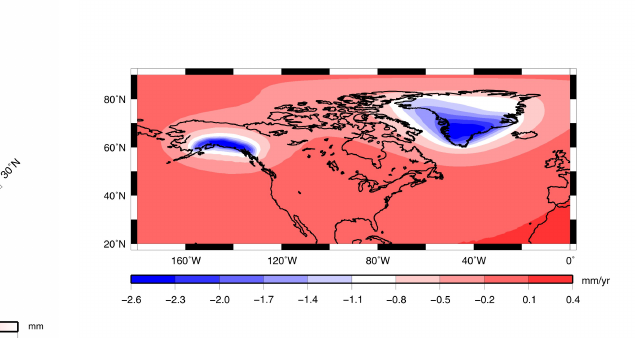
Figure 4. Pattern of the long-term hydrology variation. To compute the trend, one should multiply the pattern by the trend of 0.1 yr − 1 of the second principal component in Fig. 3.